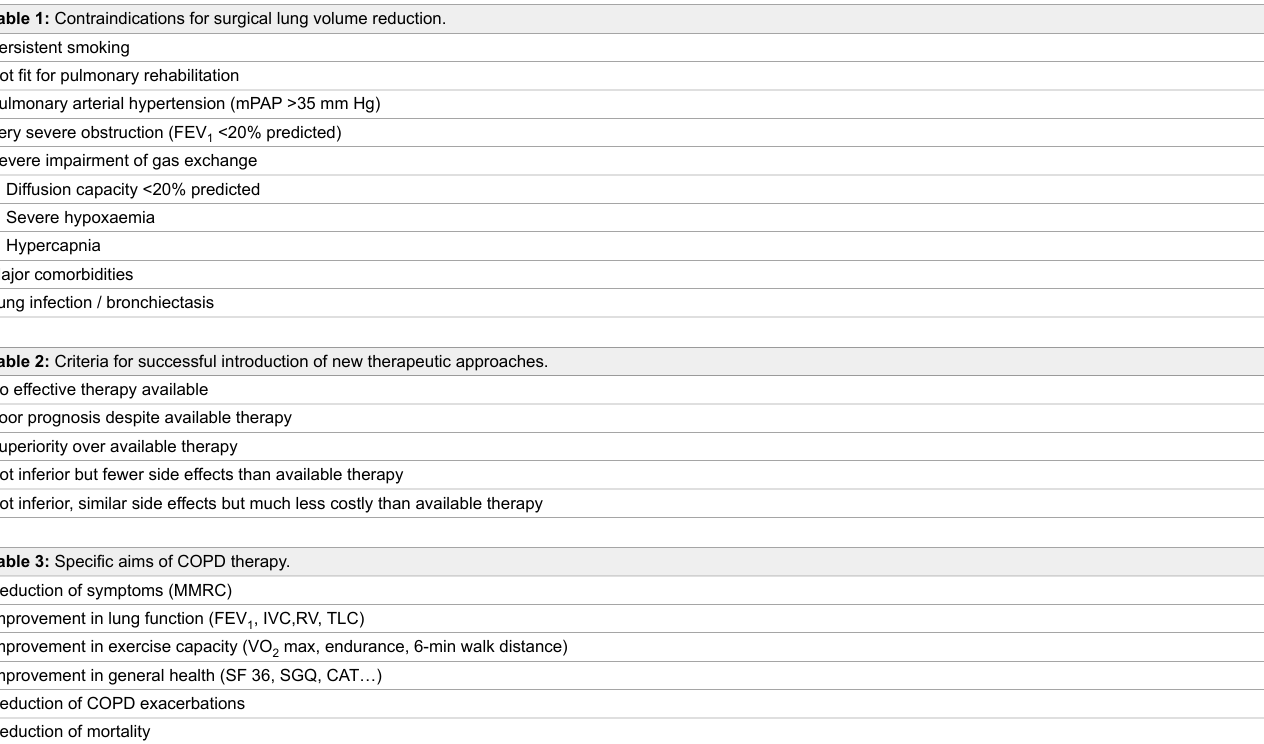
Table 3: Specific aims of COPD therapy. Reduction of symptoms